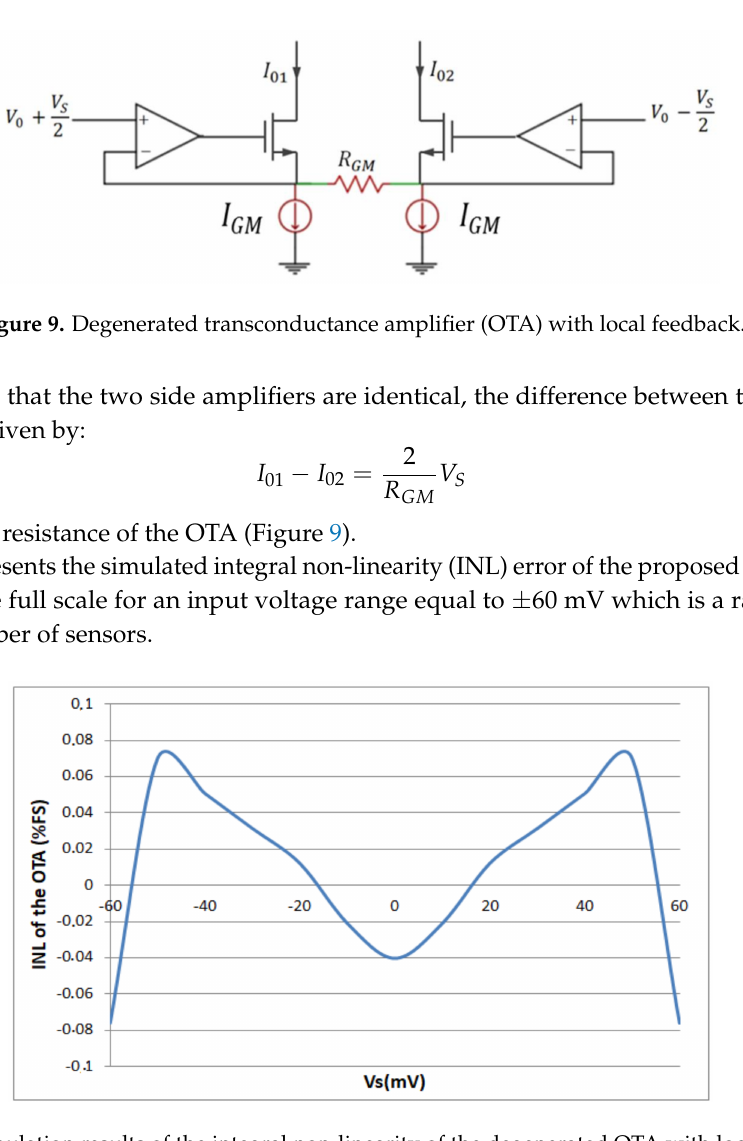
Figure 10. Simulation results of the integral non-linearity of the degenerated OTA with local